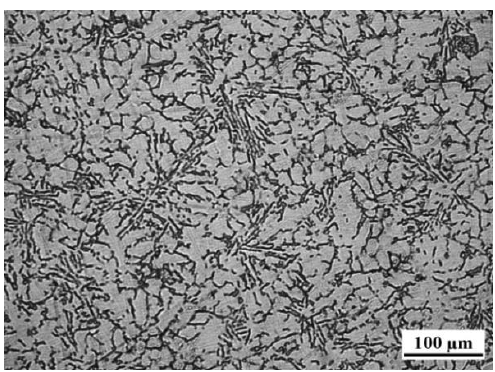
Figure 1. As-cast microstructure of A380 Al alloy during conventional solidification.